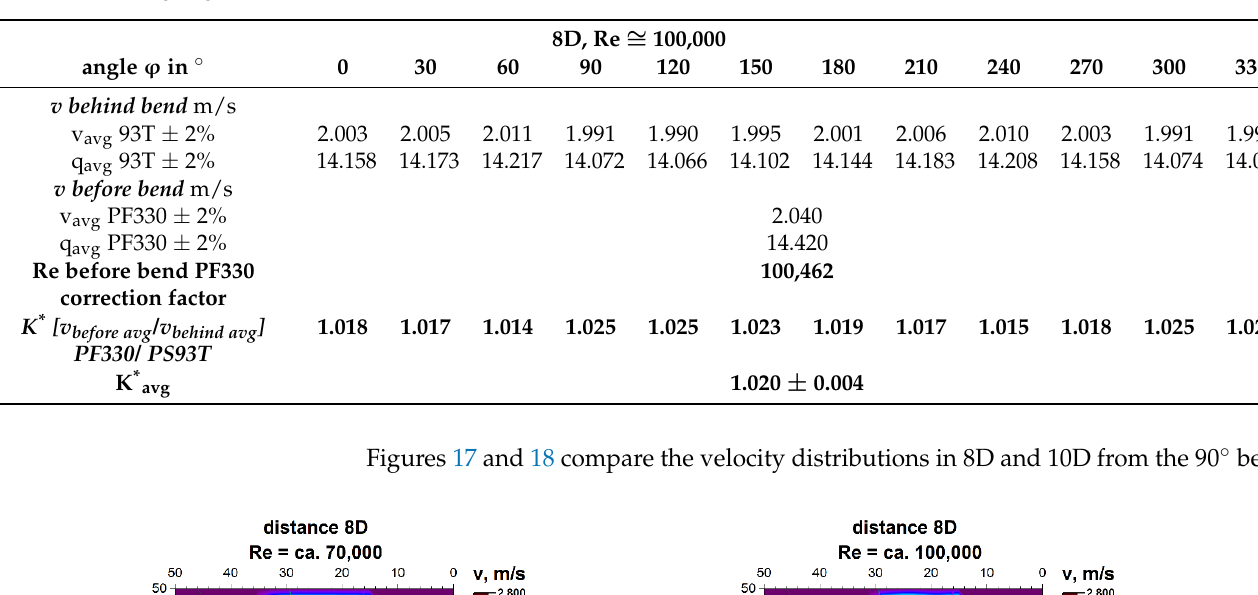
Table 8. Summary of the results of ultrasonic measurements for the 8D plane from the disturbing element as a function of the mounting angle of the ultrasonic flow meter heads, Re ∼ = 100,000.